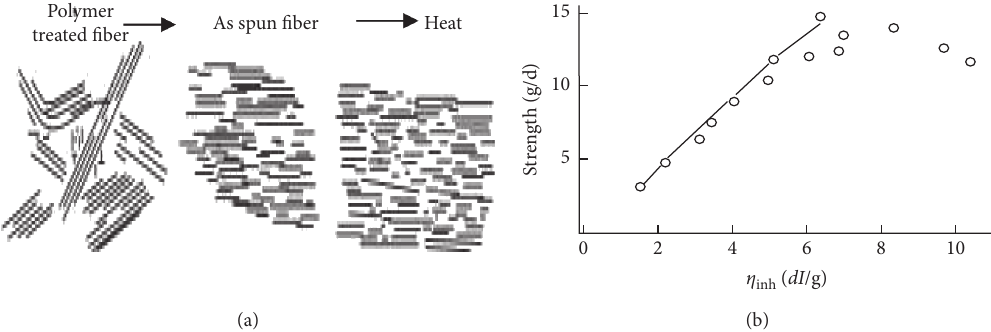
Figure 1: (a) Fiber formation of thermotropic liquid crystals; (b) inherent viscosity versus spun fiber strength [19]. Table 1: A combination of liquid crystal polymer and respective fiber property [16, 23]. Polymer